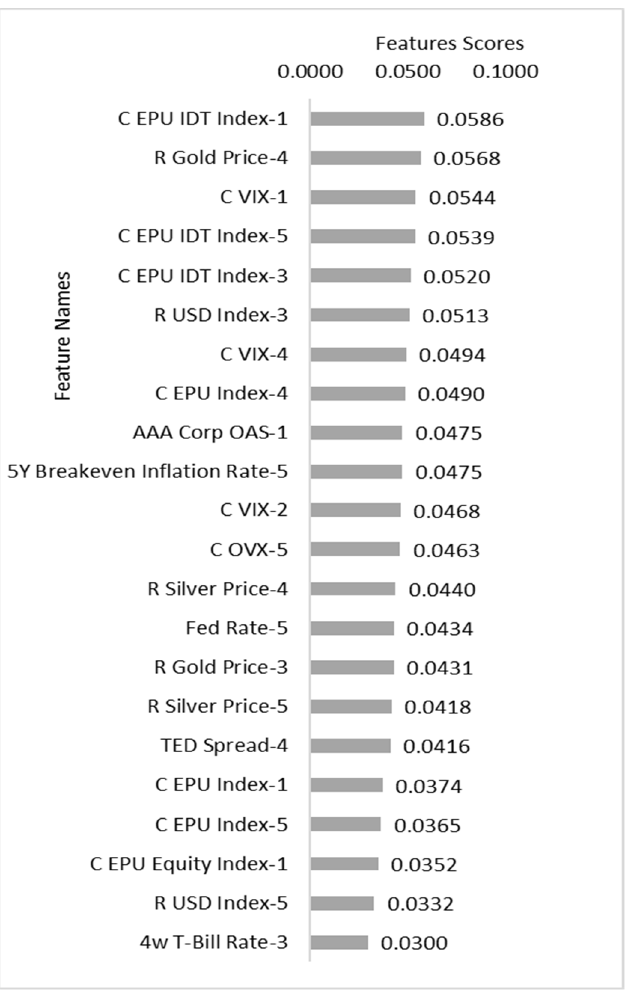
Figure 5. Top twenty-two daily ranked features from XG Boost. The numbers on the right, truncated to four decimal places, are the features’ scores.